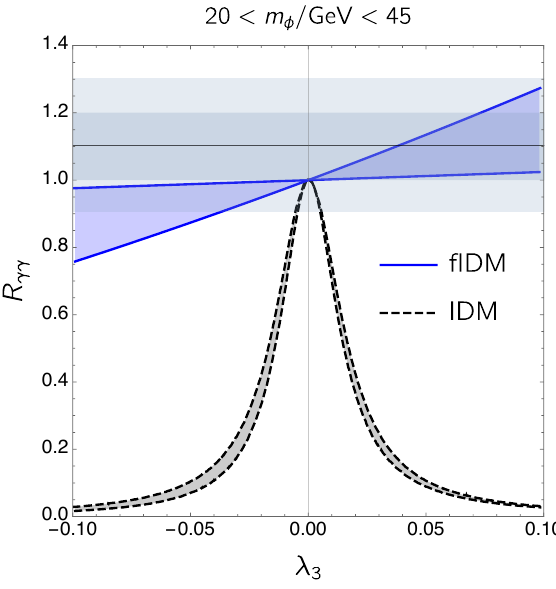
Figure 5 . Predictions for R γγ as functions of the coupling λ 3 in the fIDM (solid lines) and in the IDM (dashed lines). The degenerate doublet mass varies below the threshold: 20 < m φ / GeV < 45 . As in figure 4, the fIDM contribution is larger, because the tree-level production of fakeons in the Higgs boson decays is